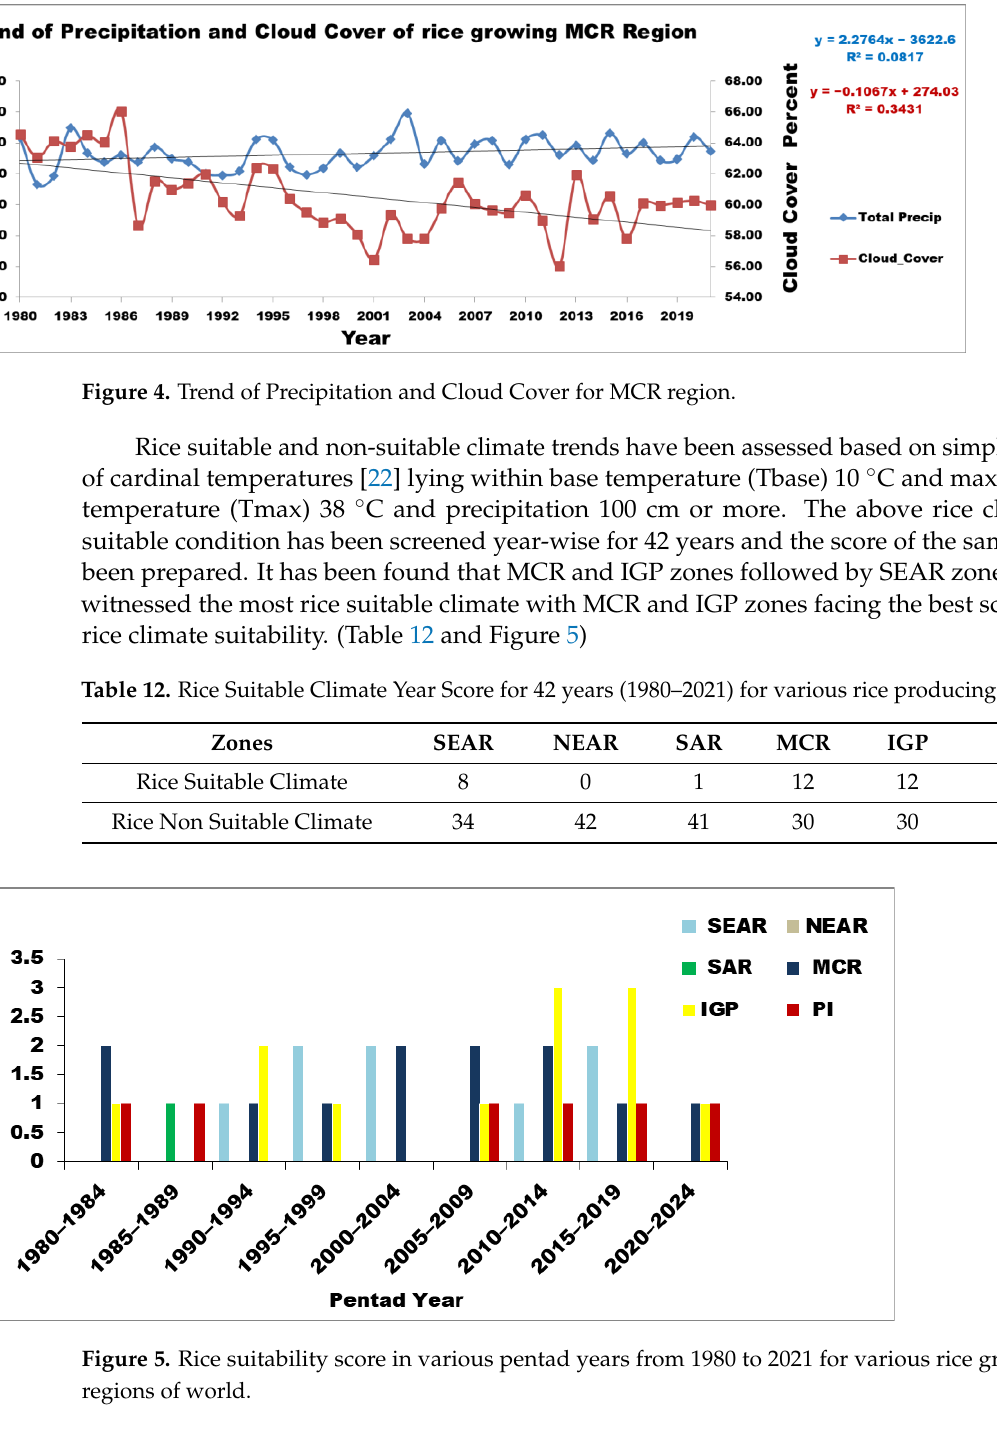
Figure 3. Trend of Precipitation and Cloud Cover for SEAR region.